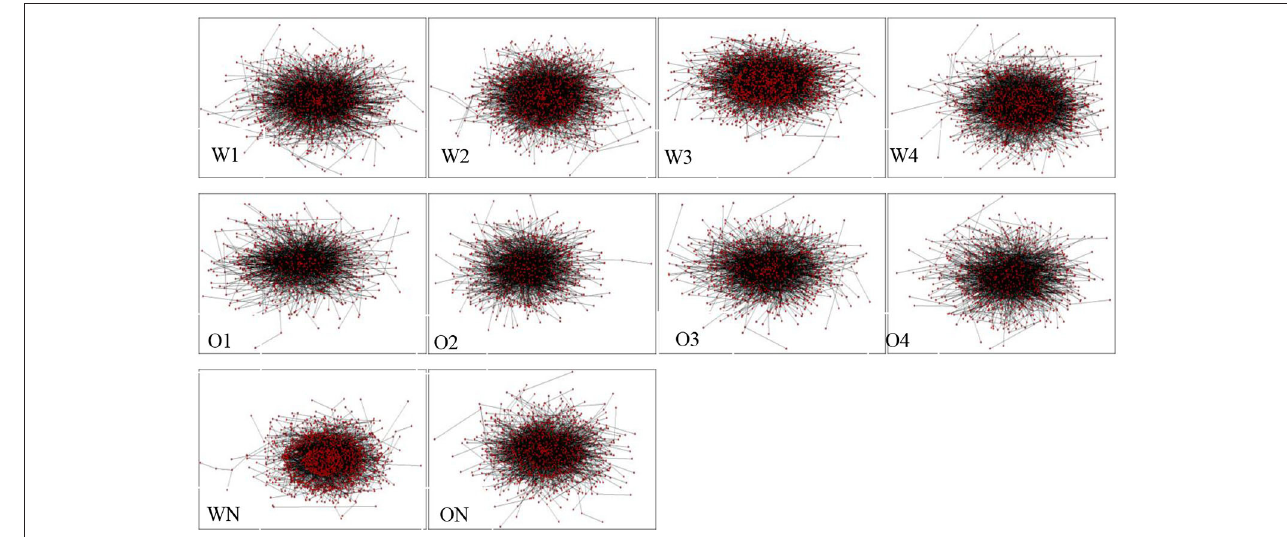
FIGURE 3 | CSL learners and native speakers’ syntactic dependency networks.